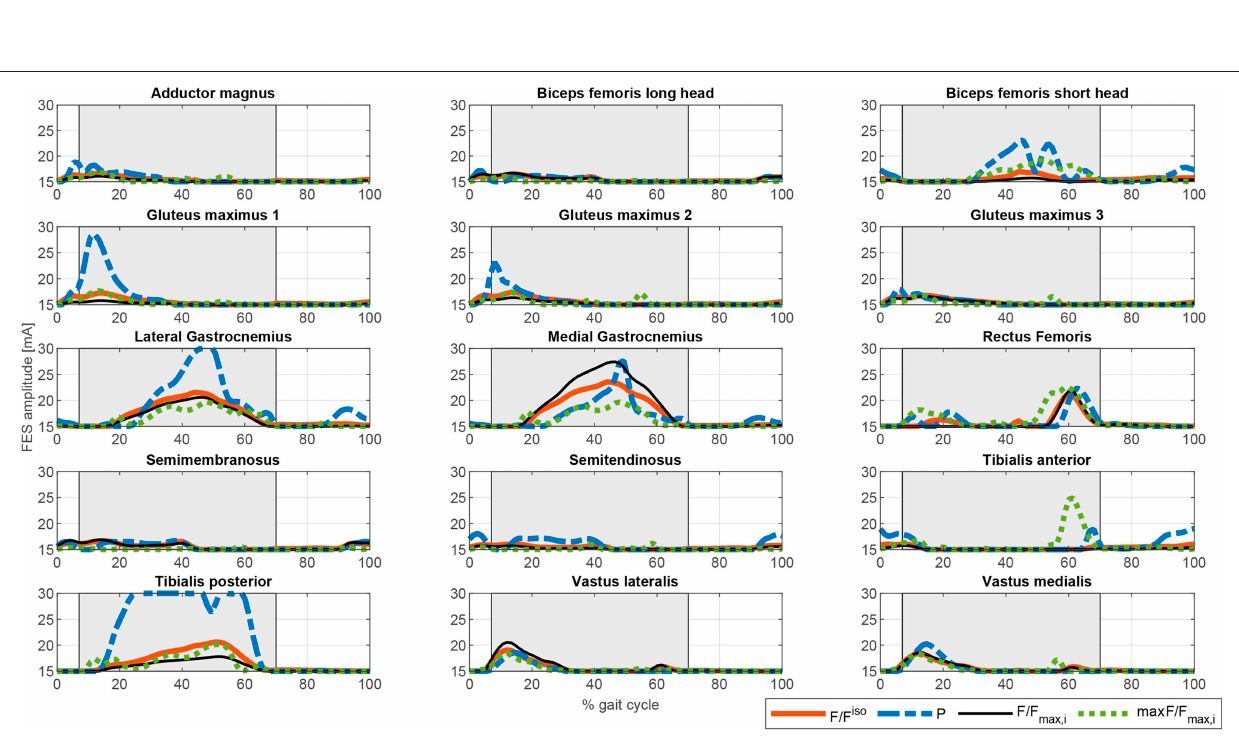
Frontiers in Neurorobotics |